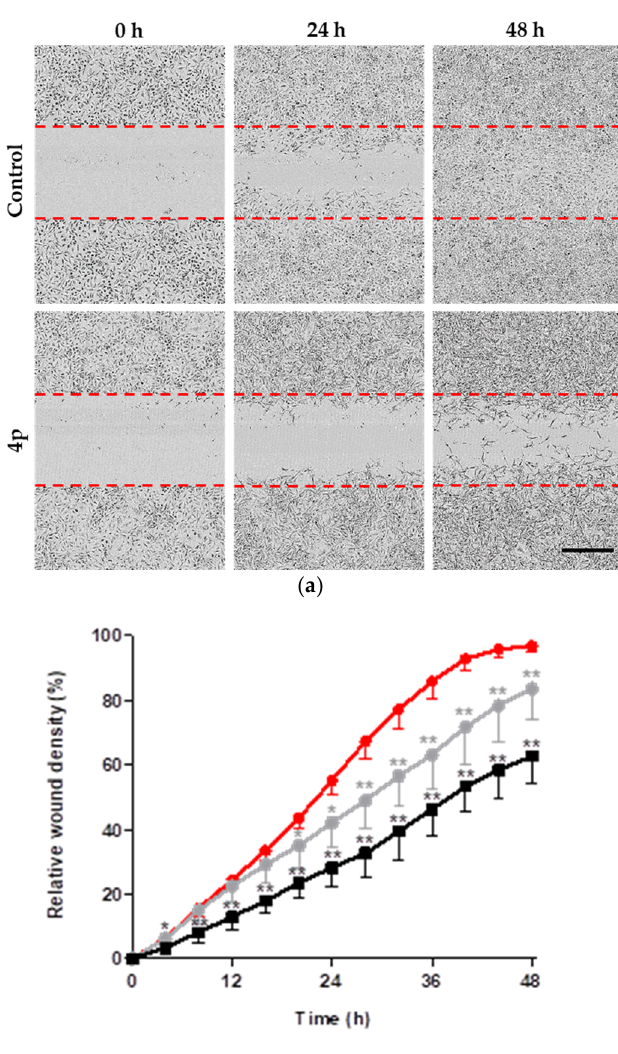
Figure 5. Inhibition of migration of A549 cells in a scratch wound assay. ( a ) Representative phase contrast images of scratch wounds in A459 cell layer grown to 100% confluence in 96-well imaging plates. Cells were treated with either vehicle (1% DMSO) or 10 µM 4p, and the wound closure was examined directly after treatment (0 h), at 24 h, and 48 h following treatment. Dashed red lines represent the initial wound width. Scale bar (400 µM) for all images is shown in black. ( b ) Time- course of the relative wound density for cells treated with 4p at 1 µM (gray) and 10 µM (black) or vehicle control (1% DMSO, red). Data represent mean ± SD from an experiment with three replicates. * p < 0.05, ** p < 0.01.